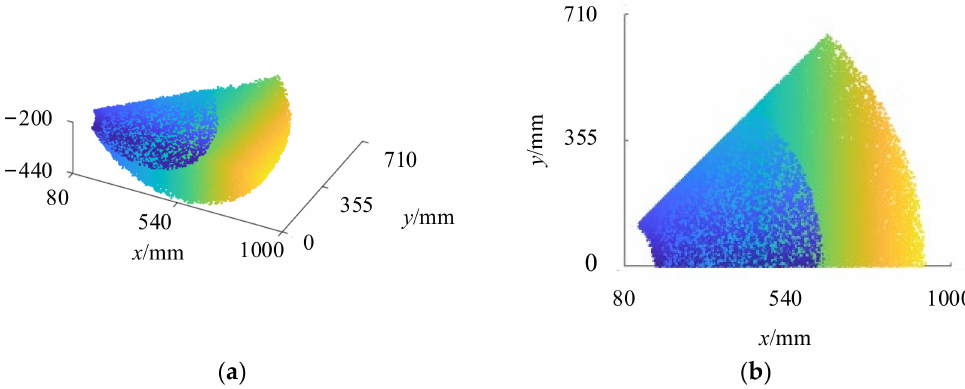
Figure 2. Range of motion analysis of ankle joint axis. ( a ) Lower limb range of motion bounded by z ≤ − 200 mm. ( b ) The x - y projection of the bounded range of motion in ( a ).